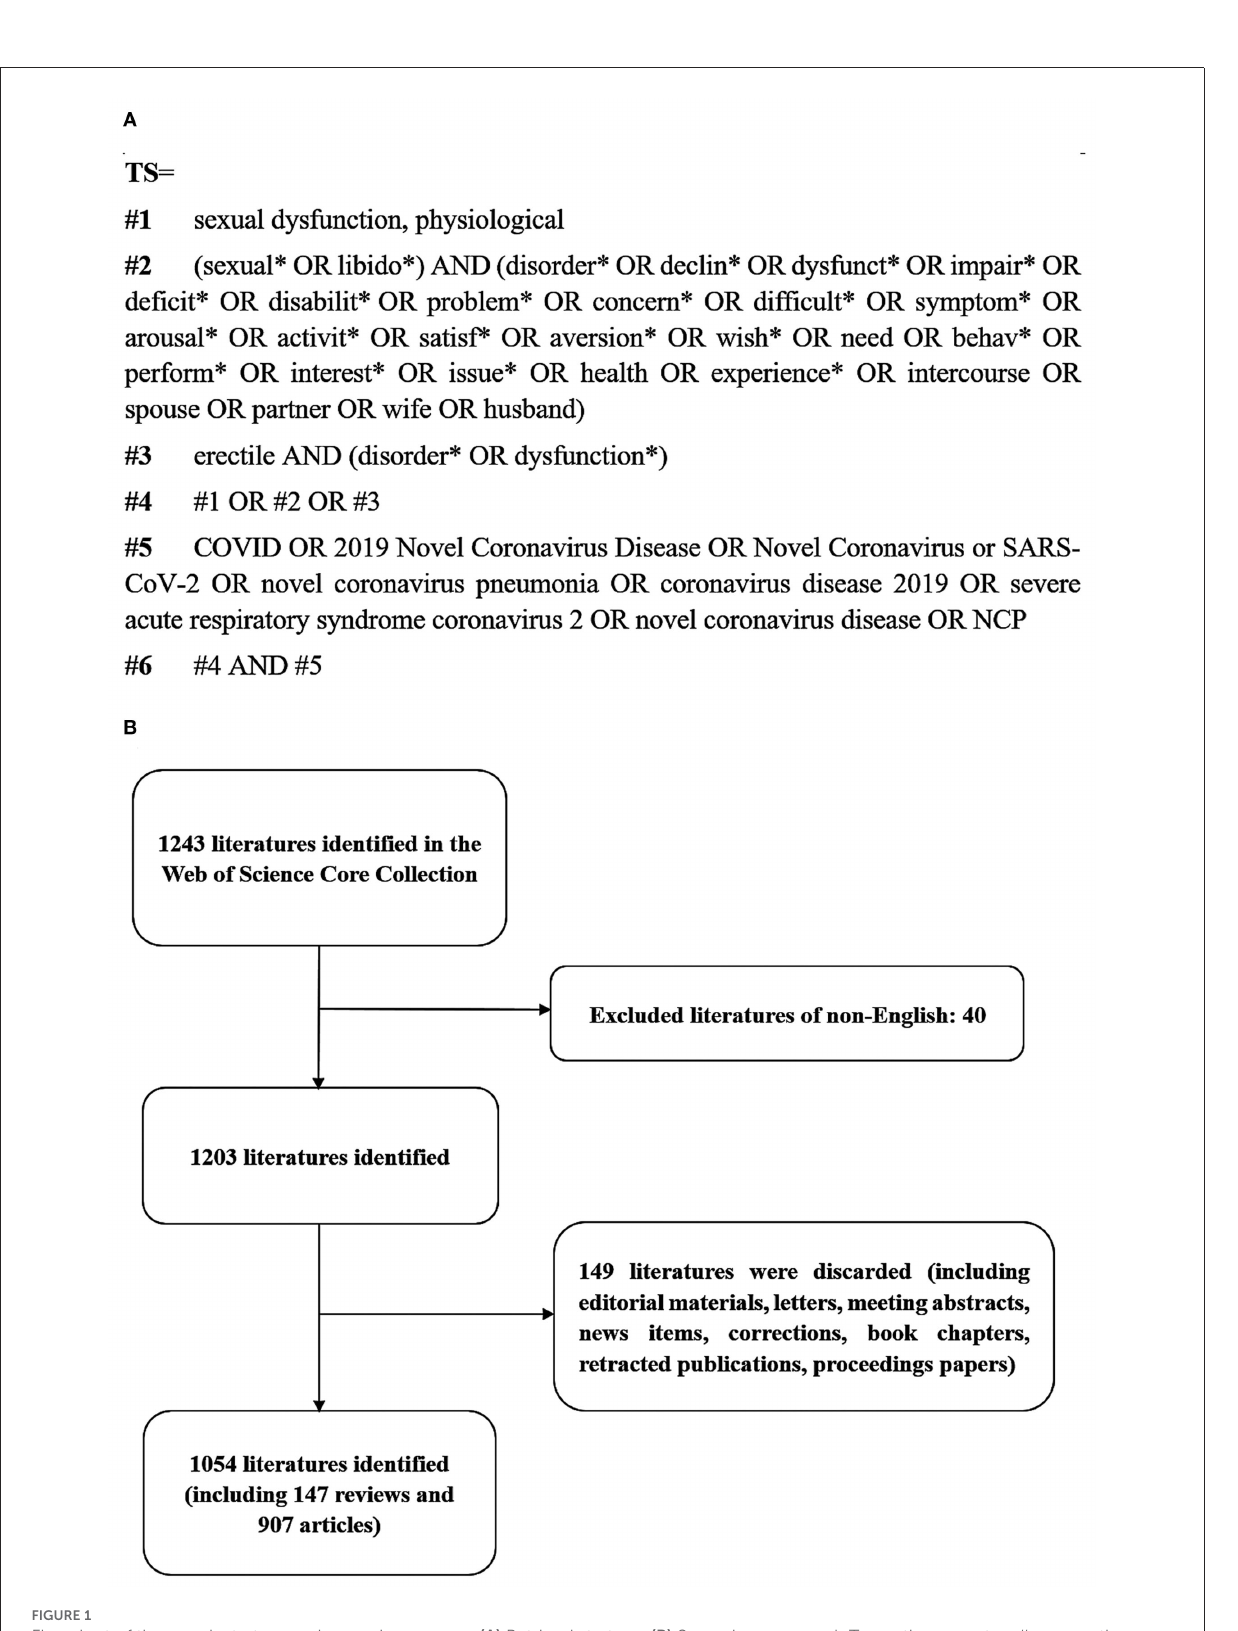
FIGURE1 Flowchart of the search strategy and screening process. (A) Retrieval strategy. (B) Screening process. *, Truncation operator; #, connection